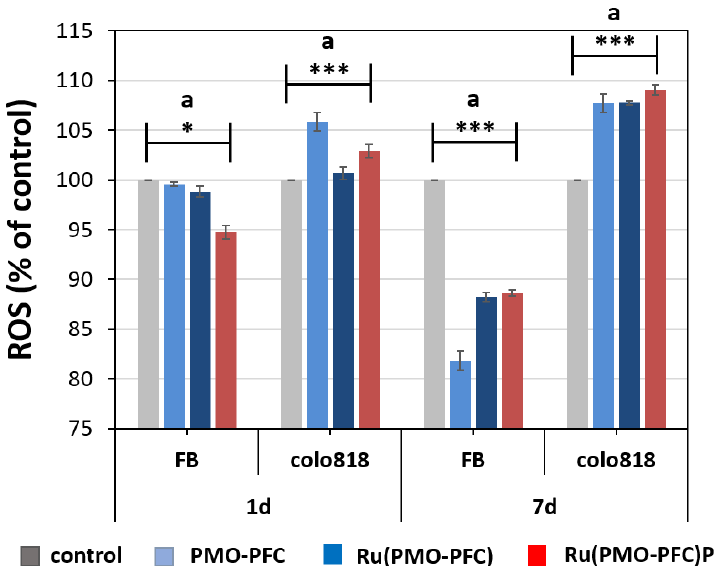
Figure 5. Relative percentages of ROS levels of FB and colo818 cells on the plate, PMO-PFC-, Ru(PMO-PFC)-, and Ru(PMO-PFC)PDL-coated culture plate under hypoxic conditions for 1 d and 7 d. The results were normalized to the control (FB or Colo 818 cells on plate). ANOVA: p < 0.05 (*), p < 0.001 (***); a = significant difference between four groups. The number of experiments is three. To examine the morphology of the cells on the particle-coated samples, cells were separately seeded on the culture plate. Cells were nuclei stained with Hoechst 33342 dye (blue) and actin-stain with phalloidin Alexa Fluor 488 dye (green). Fluorescence micros- copy was used to examine the (Figure 6). We observed that the FB cells in the samples had an elongated and stretched shape, while the colo818 cells were round. It is noted that the number of cells on the images should not be linked with cell viability as some of the cells are washed away during the washing and staining steps.